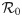
Sensitivity index of R0 with respect to χ.Sensitivity index of R0 with respect to χ for different values of V.